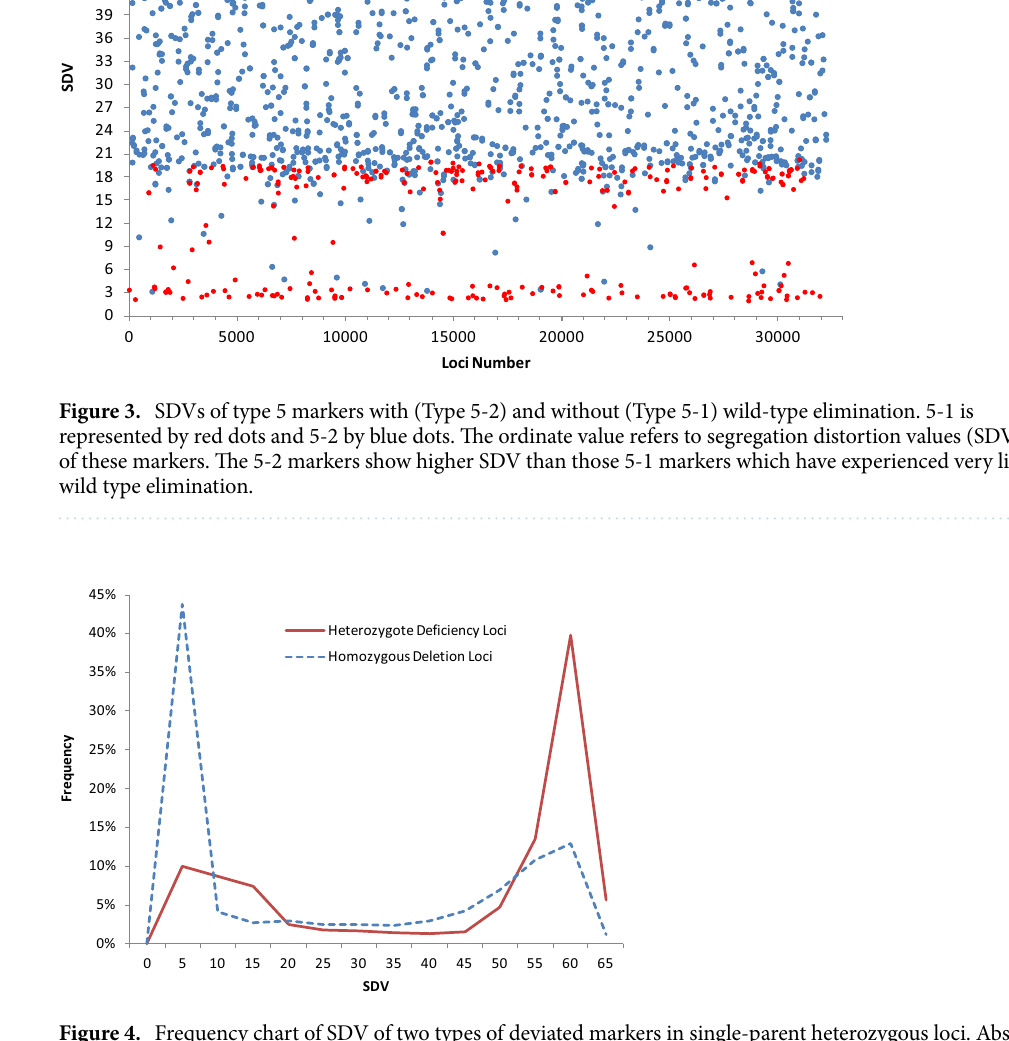
Figure 4. Frequency chart of SDV of two types of deviated markers in single-parent heterozygous loci. Abscissa shows extent of SDVs of these markers. Ordinate indicates the frequency of markers fallen into each section. Solid line represents heterozygote deficiency markers and the imaginary line represents homozygous deletion markers. The heterozygote deficiency loci show more serious distortion than homozygous deletion